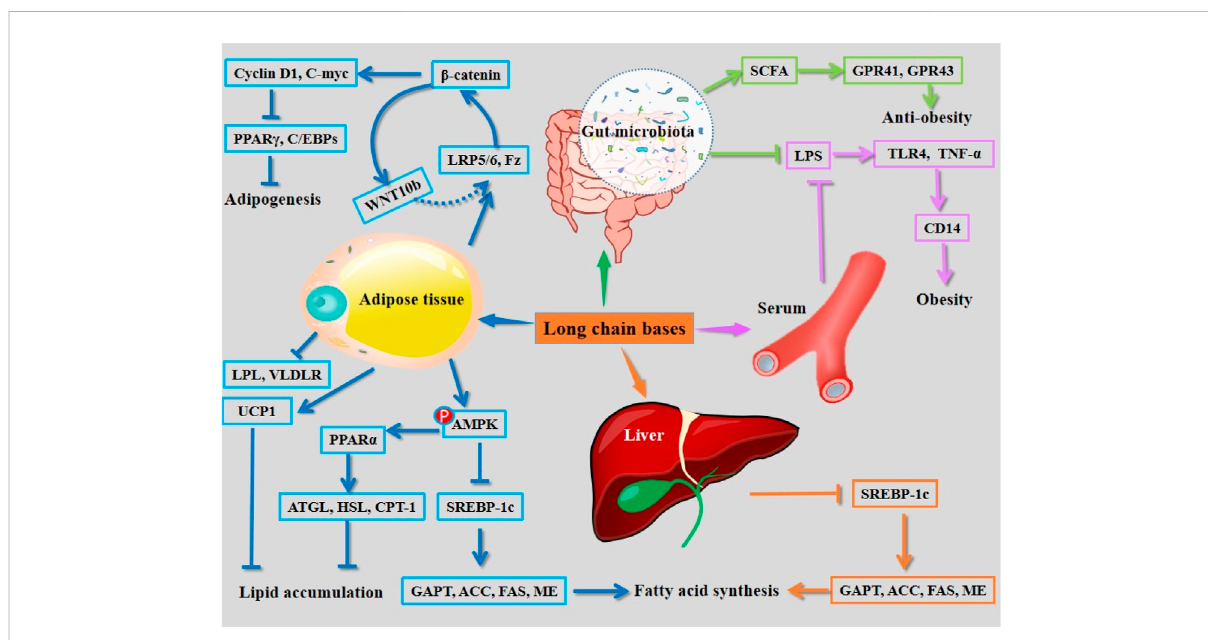
FIGURE 5 Mechanisms of action of long chain bases derived from sea cucumbers. CD14, cluster of differentiation 14; GPAT, glycerol-3-phosphate acyl- transferase; GPR, G protein-coupled receptor; LPL, lipoprotein lipase; LPS, lipopolysaccharide; SCFA, short chain fatty acid; TLR4, Toll-like receptor